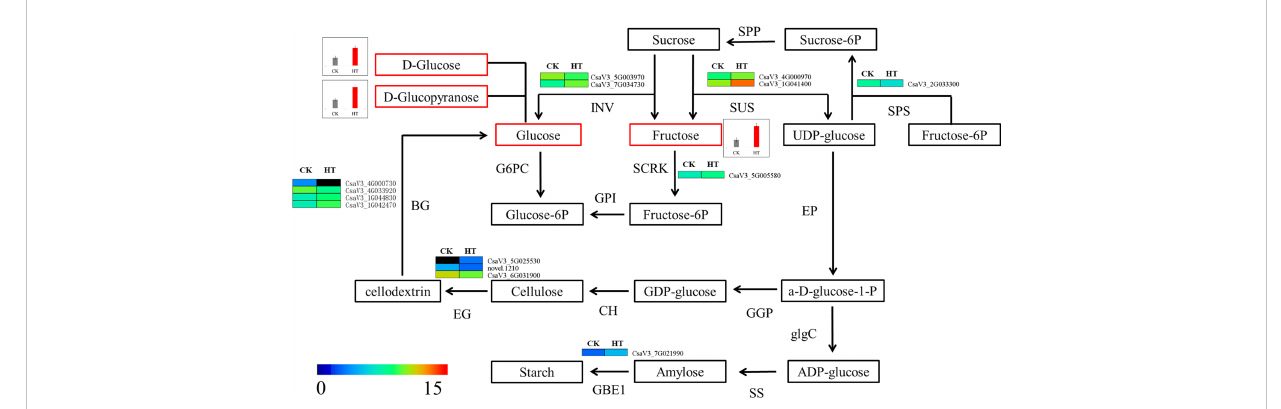
FIGURE 7 Predicted carbohydrate metabolism pathways under high-temperature stress. SPP, sucrose-6-phosphatase; INV, invertase; SUS, sucrose synthase; SPS, sucrose-phosphate synthase; G6PC, glucose-6-phosphatase; SCRK, fructokinase; GPI, glucose-6-phosphate isomerase; EP, ectonucleotide pyrophosphatase; glgC, glucose-1-phosphate adenylyltransferase; SS, starch synthase; GBE1, glucan branching enzyme; CH, cellulose synthase; EG, endoglucanase; BG,